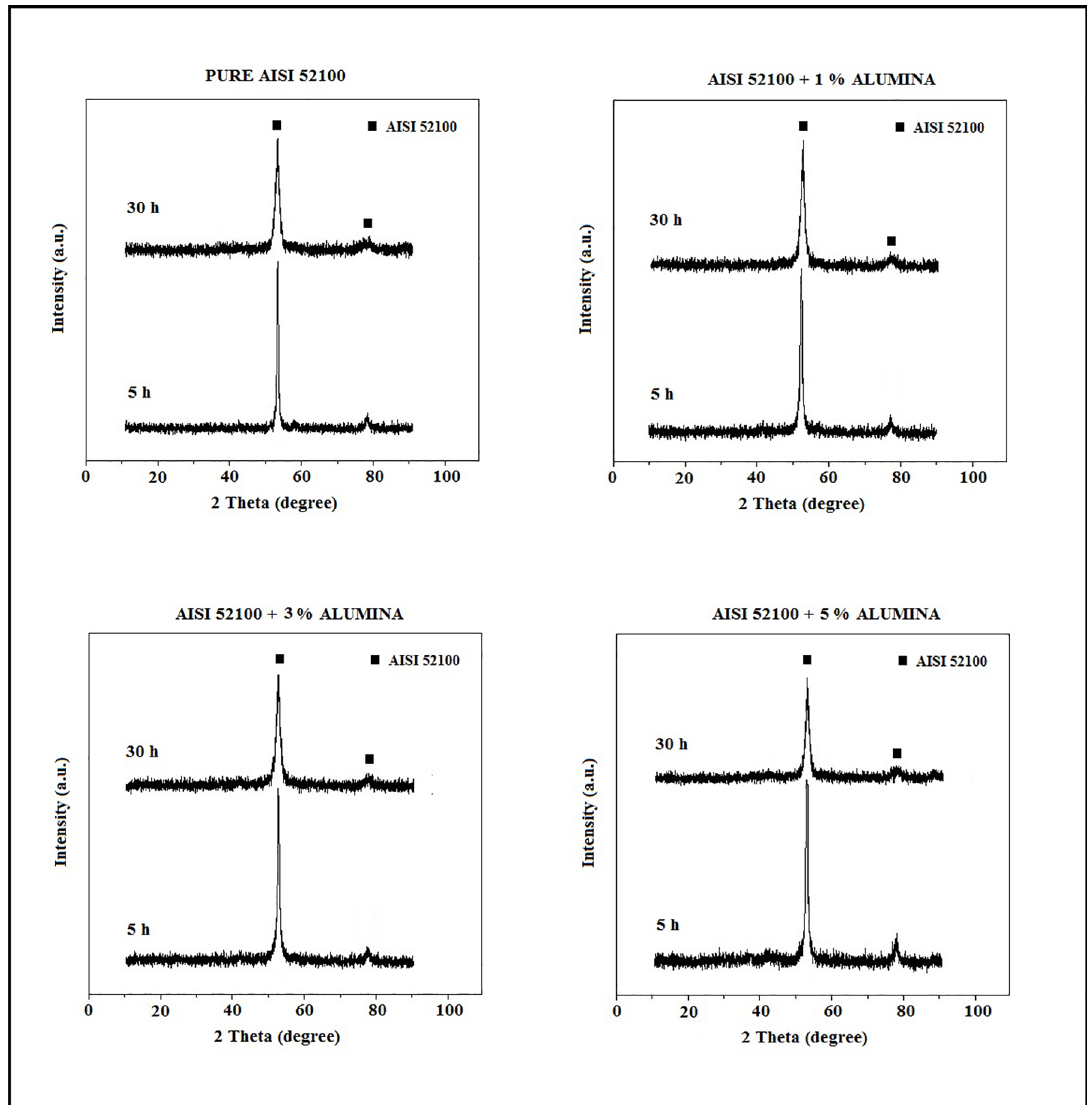
Figure 6. Amorphization analysis via x-ray diffraction after high energy ball milling for all of the conditions